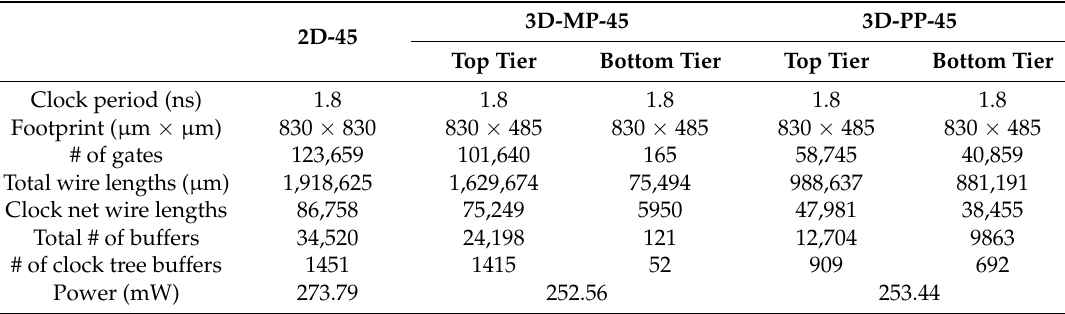
Table 7. Overall layout results of 2D and 3D ICs designed in 45-nm process